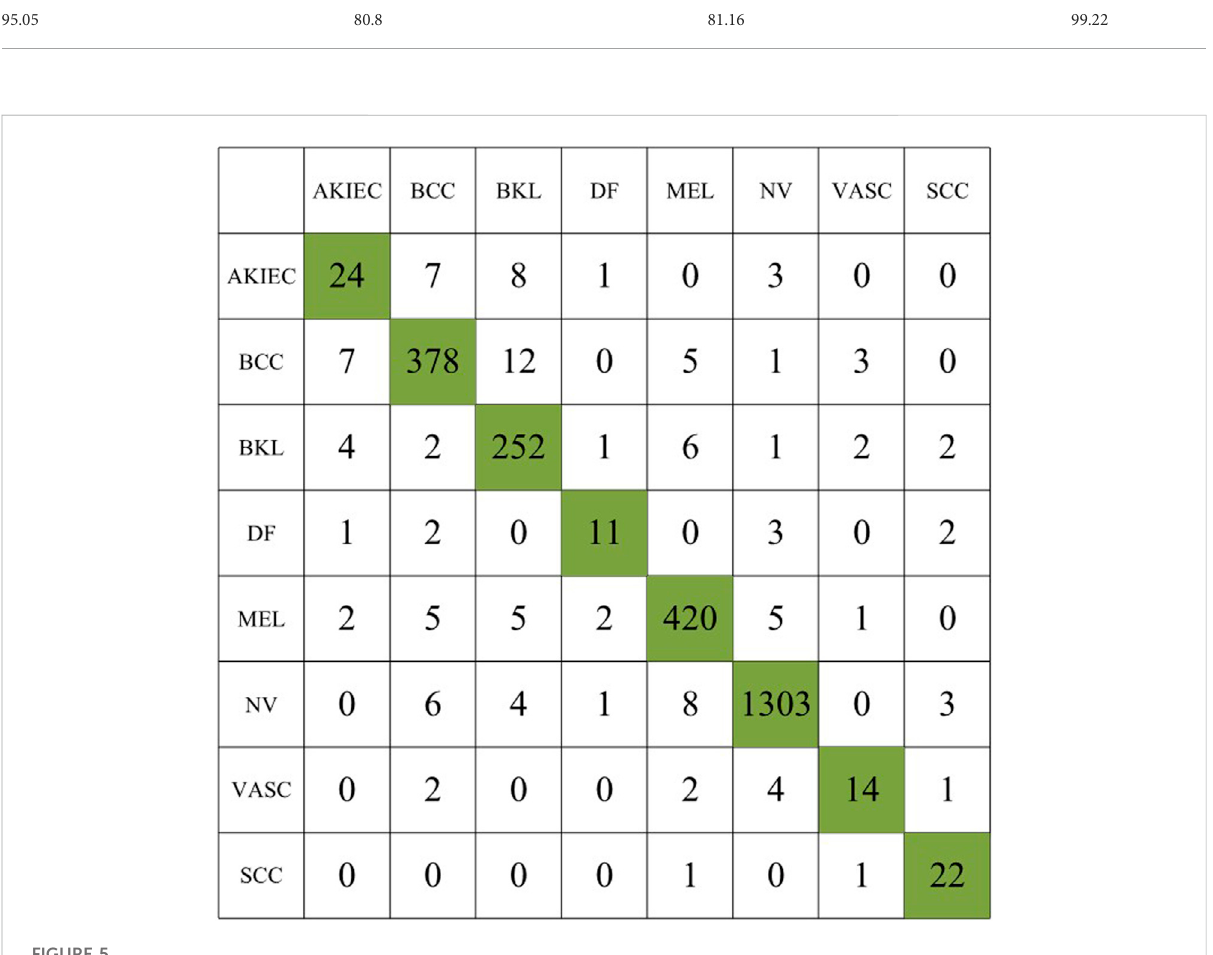
FIGURE 5 Confusion matrix for the fi rst